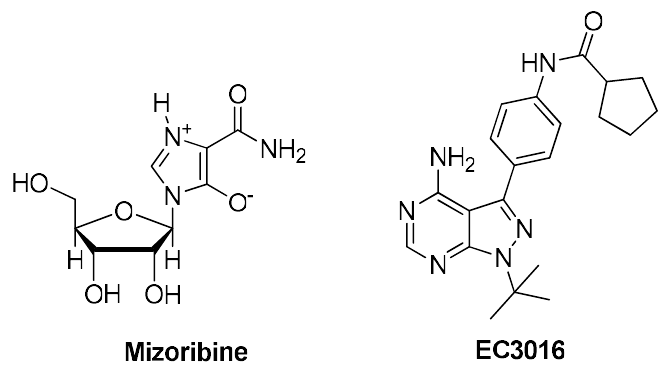
Figure 2. Chemical structures of Hsp60 inhibitors binding the ATP binding site.